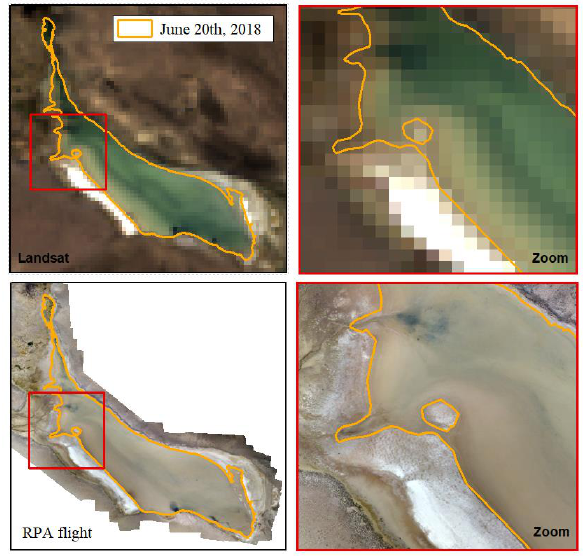
Figure 3. Parincota wetland, Isluga Volcano National Park.